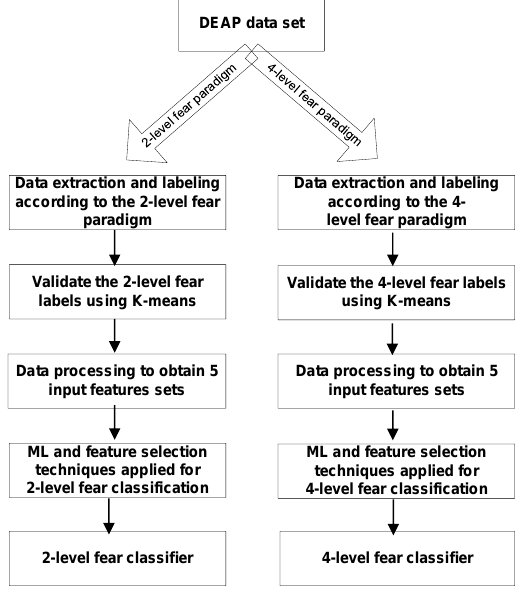
Figure 1. Steps for obtaining the two classifiers.